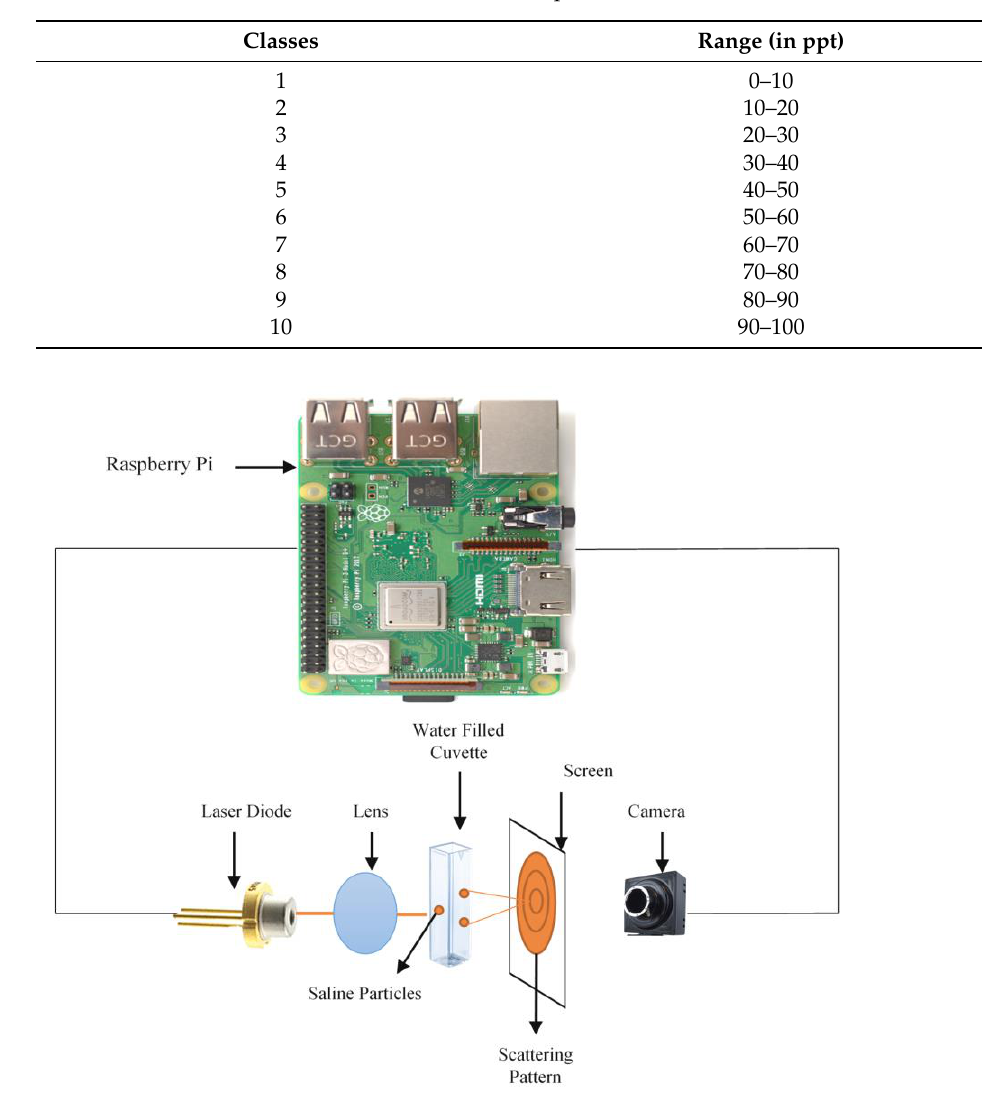
Figure 1. Schematic representation for determining the scattering image pattern.